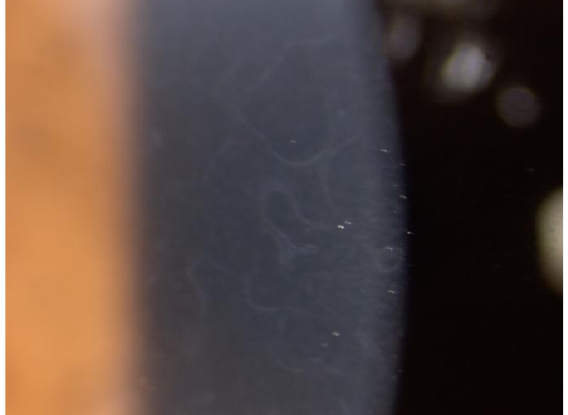
Figure 1. Anterior segment color photograph of Epithelial Basement Membrane Dystrophy one of the eyes included in this study.